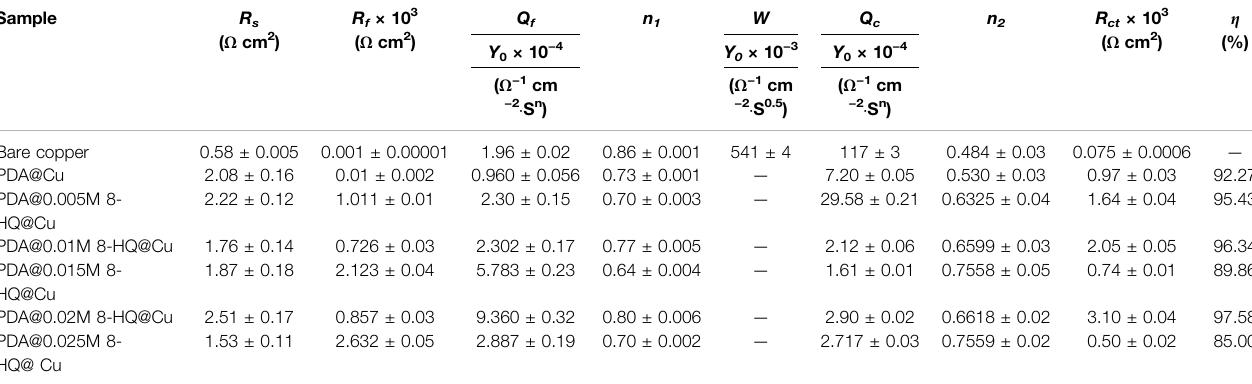
TABLE3| ElectrochemicalparameterscalculatedfromEISmeasurementsfordifferentsamplesin3.5 wt.%NaClaqueoussolution(Theerrormeansastandarddeviationof three measurements).